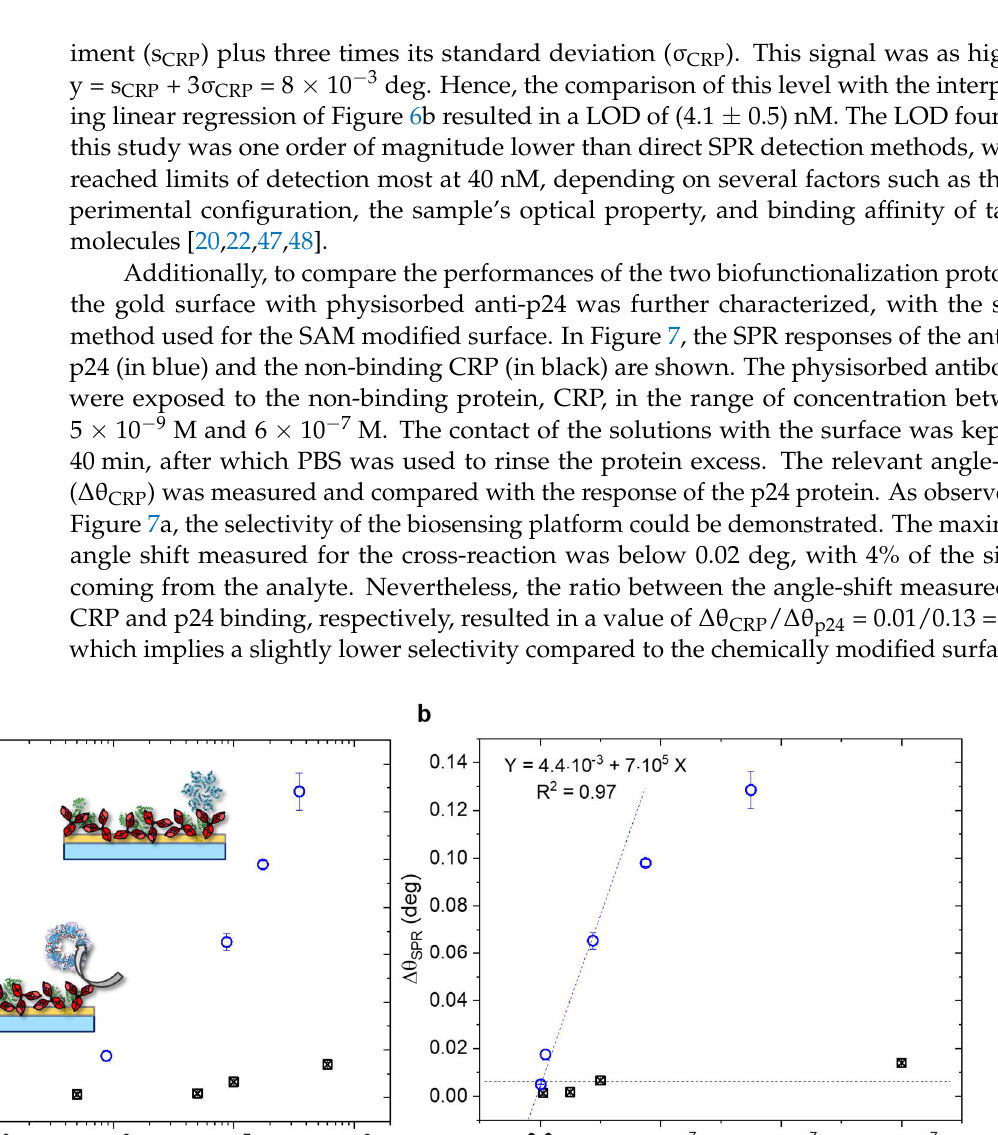
Table 4. Summary of the analytical figures of merit of the two biomodification methods with anti- p24 for the detection of the p24 protein.